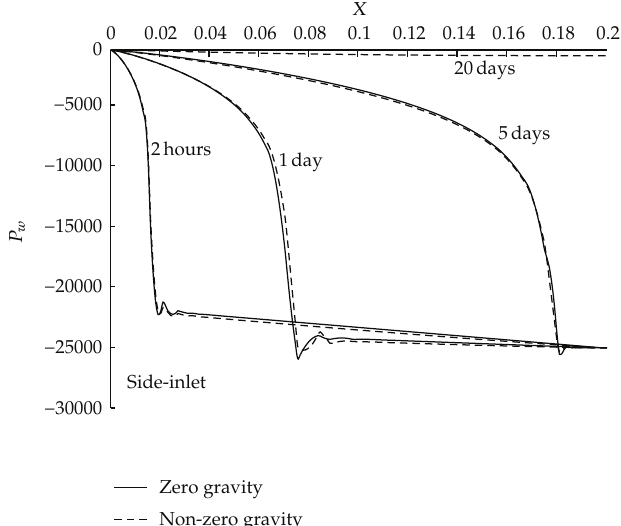
Figure 5: Comparison between considering and neglecting gravity e ff ect on water pressure for the side- inlet case, at z (cid:8) 0 .